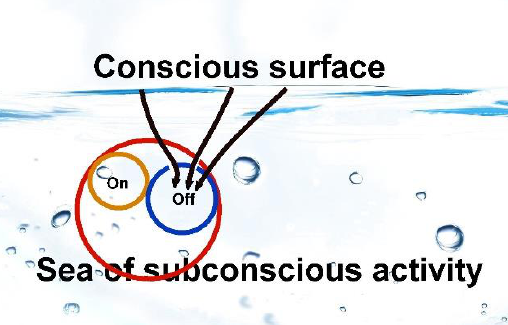
Figure 3. Exercising relevant apps. Although the apps that control feelings belong to the nonconscious brain, there are ways to use conscious processes to impact on their activity, as indicated by the arrows. The idea may be to strengthen the capacity to turn off negative feelings, such as those generated by the fear app (red circle).